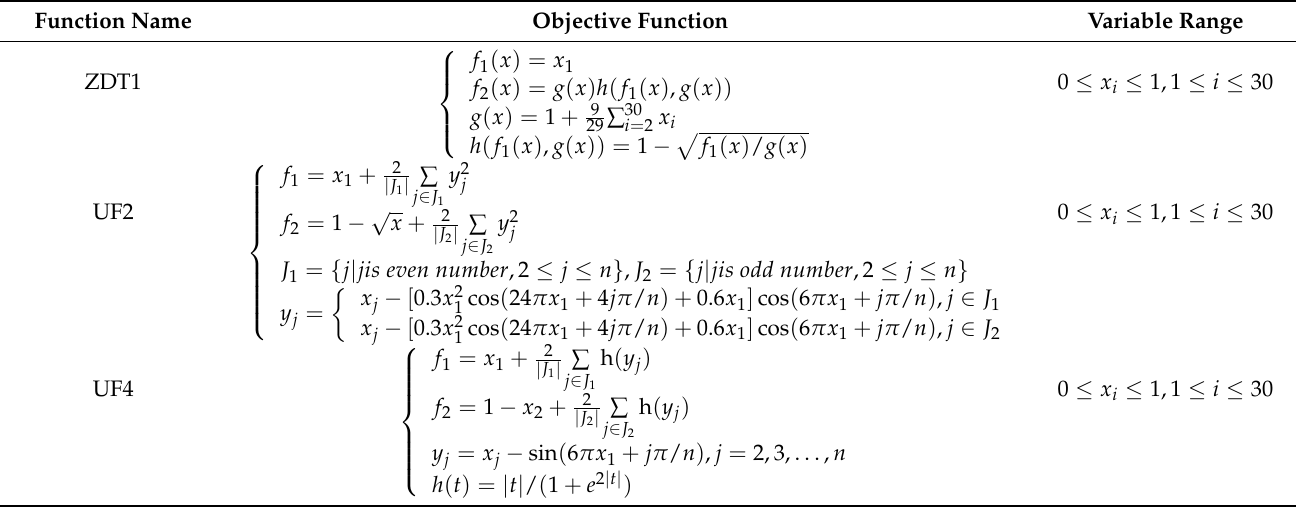
Table 1. Benchmark functions for multiobjective optimization test of NSGWO algorithm.